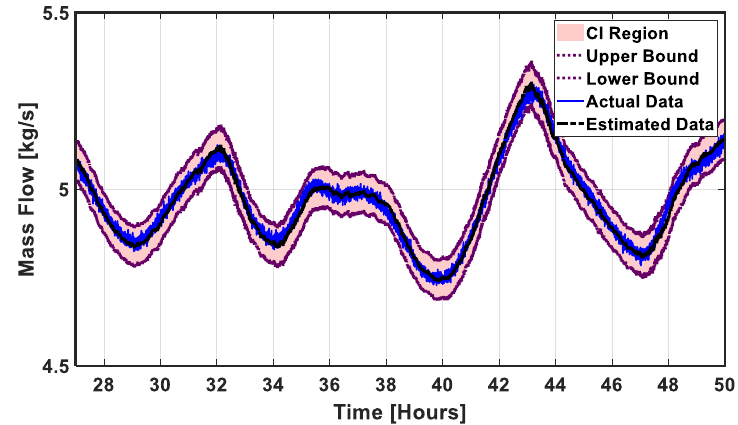
Figure 8. Testing of Hammerstein model with 0% leak at 30 h, 1201 parameters and 0.2% noise ratio.